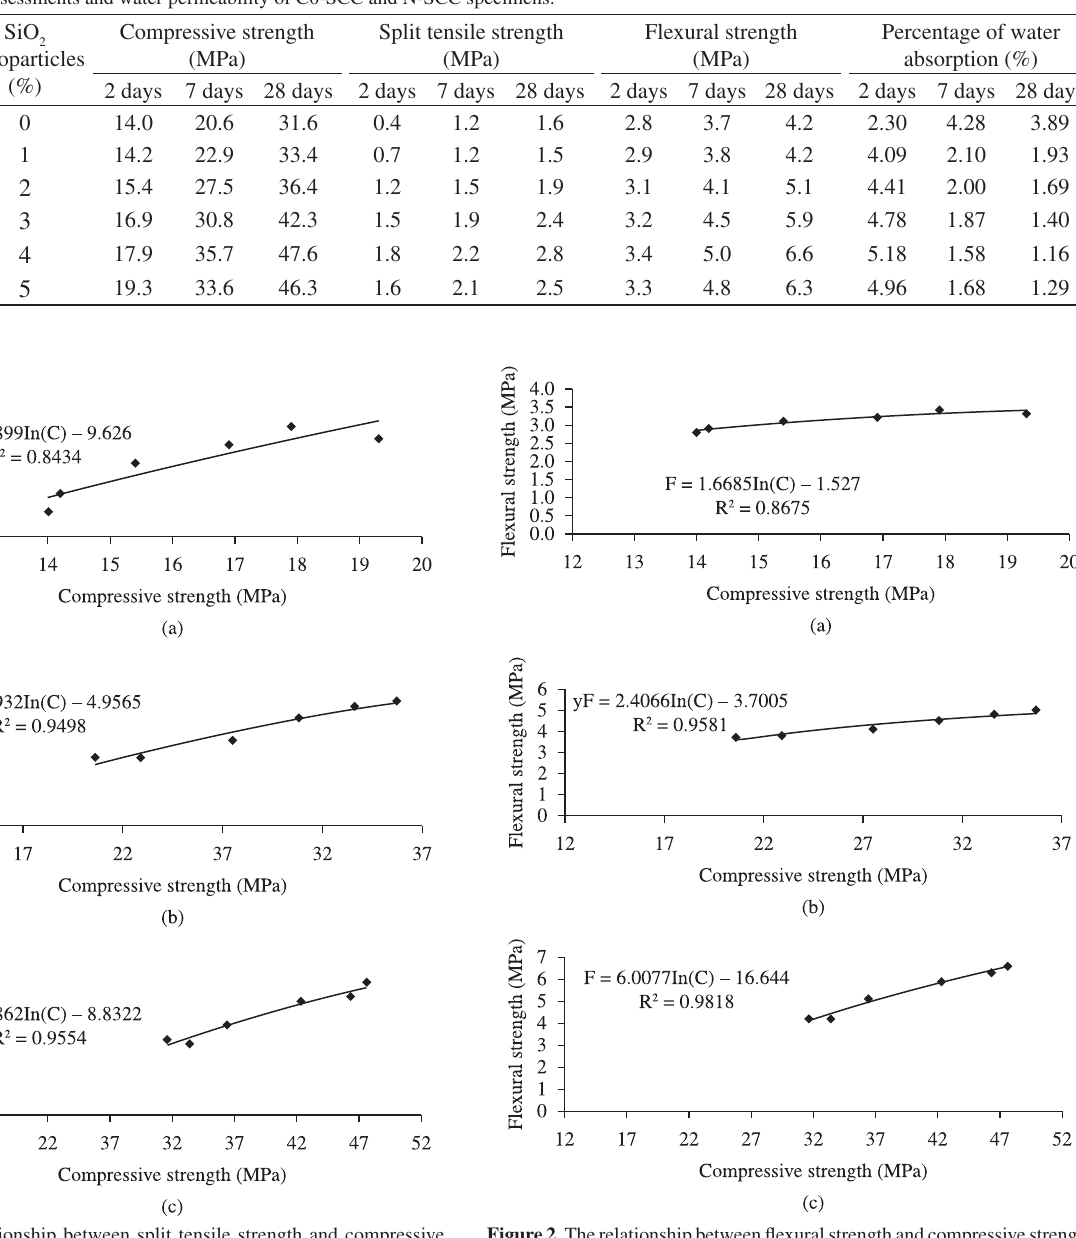
Figure 1. The relationship between split tensile strength and compressive strength of the specimens cured at a) 2 days; b) 7 days; and c) 28 days. C denotes compressive strength and S denotes split tensile strength.